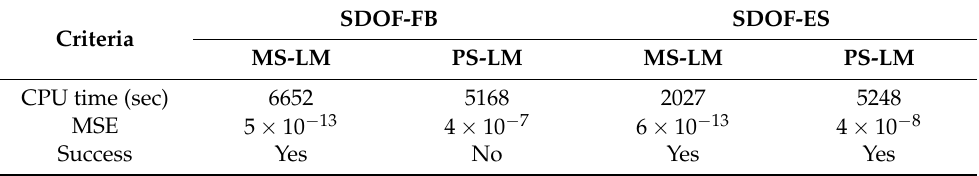
Table 3. Parameters assigned for nonlinearities in the example SDOF systems.